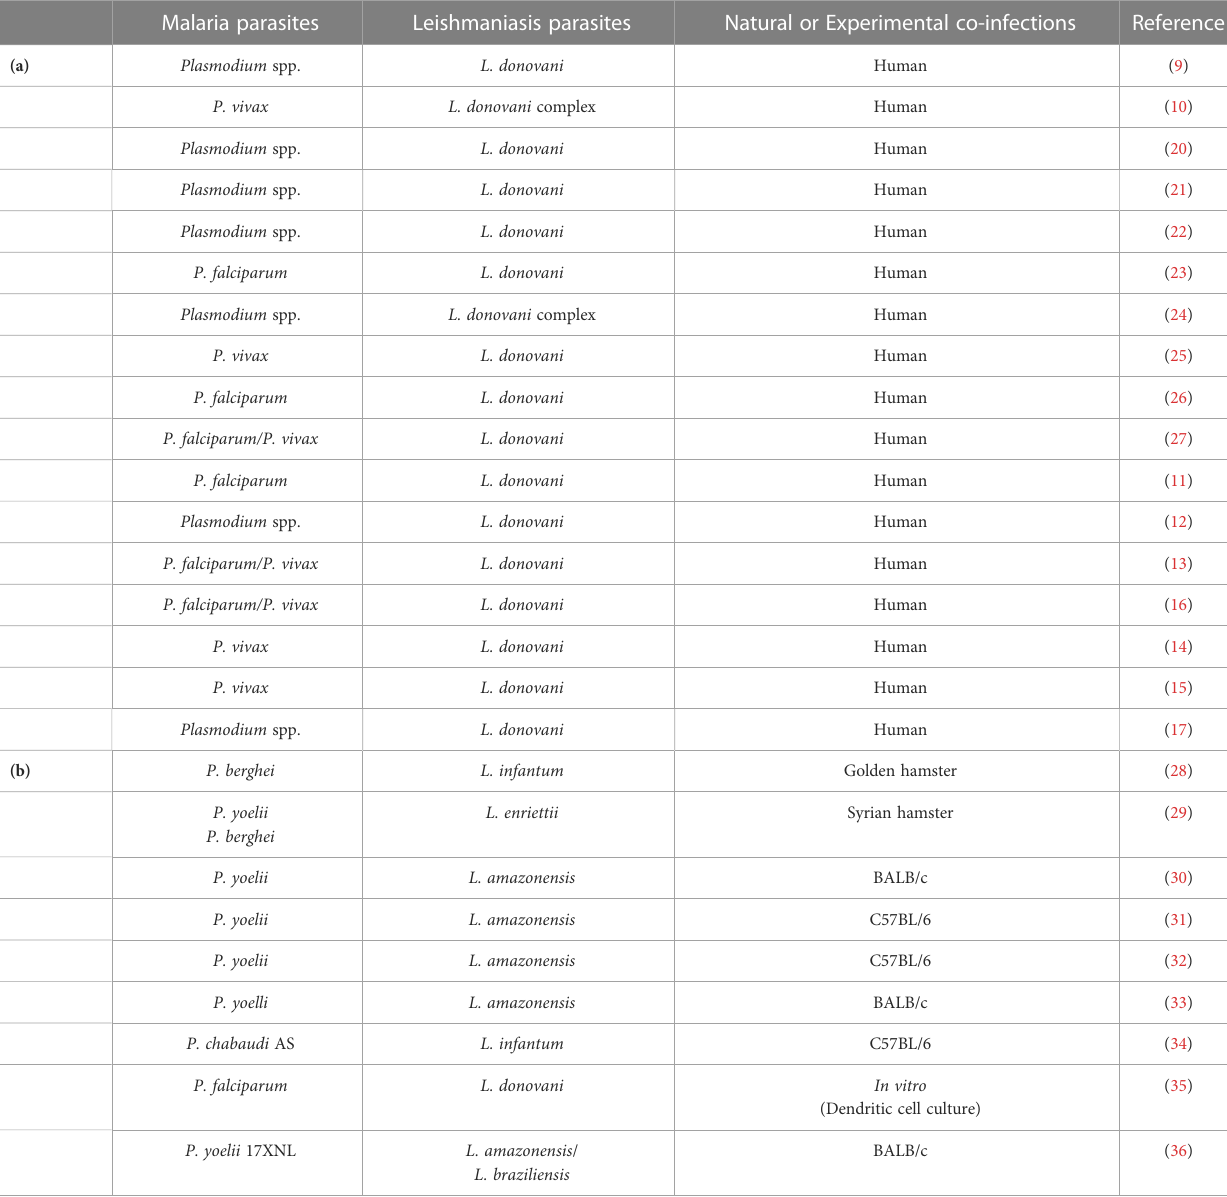
TABLE 1 Cases and studies on Plasmodium spp. and Leishmania spp. Malaria parasites Leishmaniasis